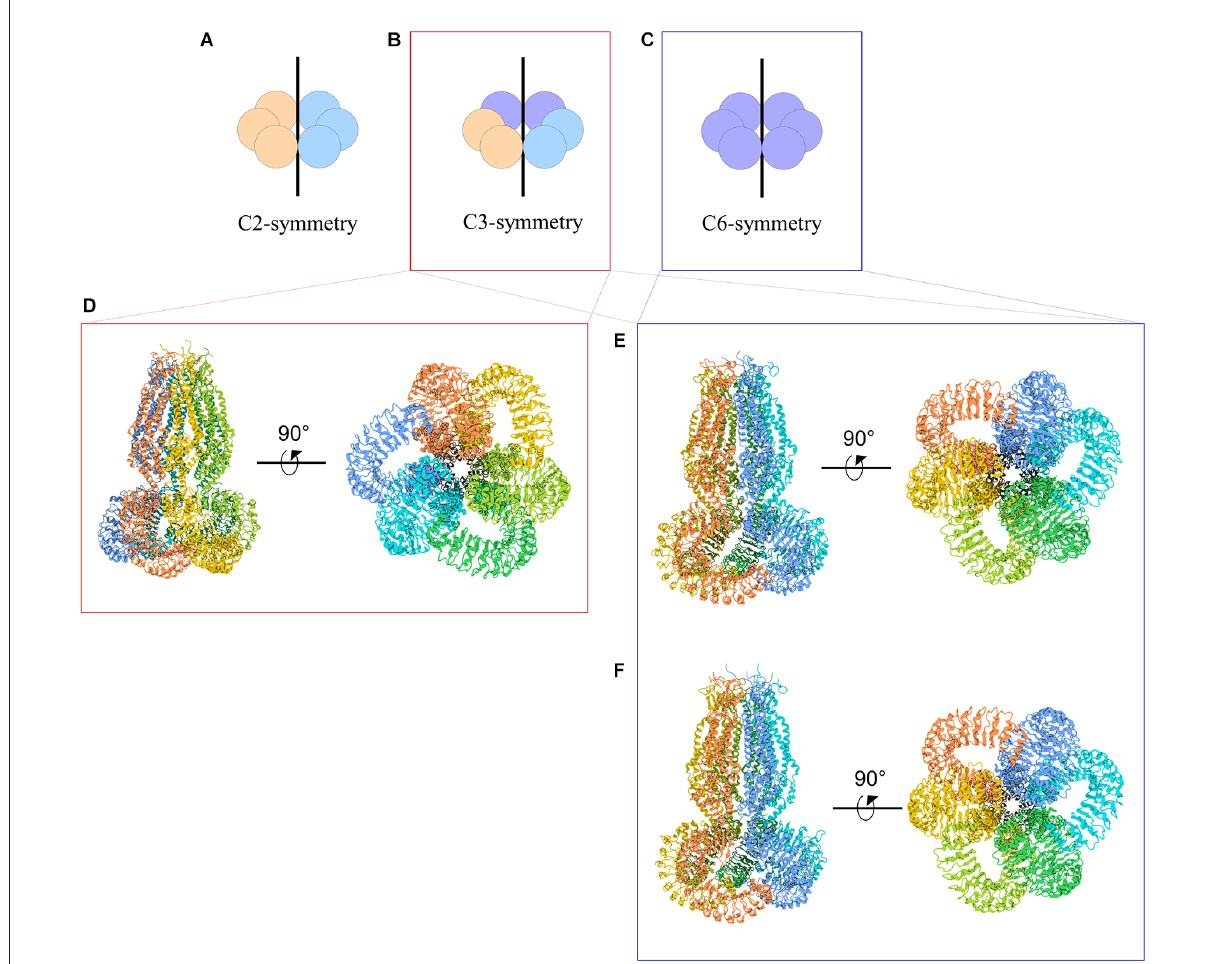
FIGURE3 Cartoon representations of LRRC8A homohexameric channels and their symmetries. (A–C) Schematic representations of homohexameric channel symmetries. (A) C2 symmetry wherein three subunits take on a specific steric conformation (orange), and the other three subunits take on another conformation (blue). This is also referred to as a “dimer of trimers.” (B) C3 symmetry wherein two subunits take on the first conformation (orange), two subunits take on a second conformation (blue), and the remaining two subunits take on a third conformation (purple). This is also referred to as a “trimer of dimers.” (C) C6 symmetry, wherein each subunit takes on the same conformation. (D–F) Cryo-EM structures of LRRC8A homomeric channels. (D) Human homohexameric LRRC8A channel (RCSB 5ZSU) at 4.25 Å. C3 symmetry (Kasuya et al., 2018). (E) Human homohexameric LRRC8A channel (RCSB 6DJB) at 4.4 Å. C6 symmetry at the ECD, TMD, and ICD; C3 symmetry at the LRRD (Kefauver et al., 2018). (F) Mouse analog of homohexameric LRRC8A channel (RCSB 6G9O) at 4.25 Å. C6 symmetry at the ECD, TMD, and ICD; C3 symmetry at the LRRD (Deneka et al.,